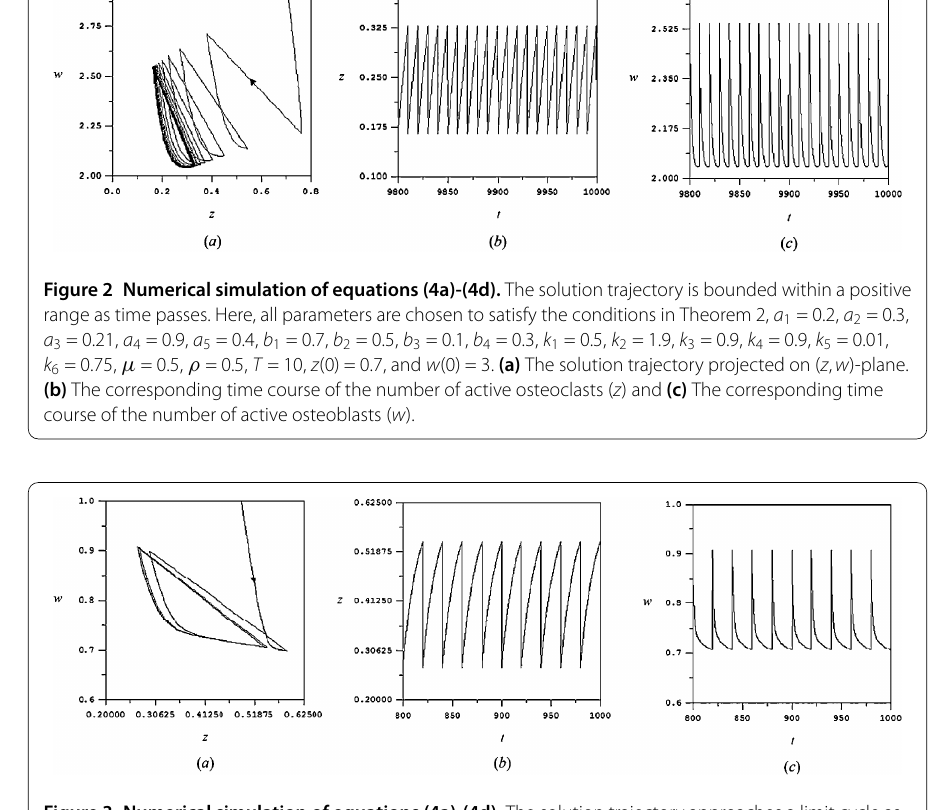
Figure 3 Numerical simulation of equations (4a)-(4d). The solution trajectory approaches a limit cycle as time passes. Here, all parameters are chosen to satisfy the conditions in Theorem 3, a 1 = 0.75, a 2 = 0.3, a 3 = 0.35, a 4 = 0.9, a 5 = 0.4, b 1 = 0.7, b 2 = 0.5, b 3 = 0.1, b 4 = 0.6, k 1 = 0.5, k 2 = 2.9, k 3 = 0.9, k 4 = 0.95, k 5 = 0.21, k 6 = 0.7, μ = 0.2, ρ = 0.5, T = 20, z (0) = 0.13, and w (0) = 5. (a) The solution trajectory projected on ( z , w )-plane. (b) The corresponding time course of the number of active osteoclasts ( z ). (c) The corresponding time course of the number of active osteoblasts ( w